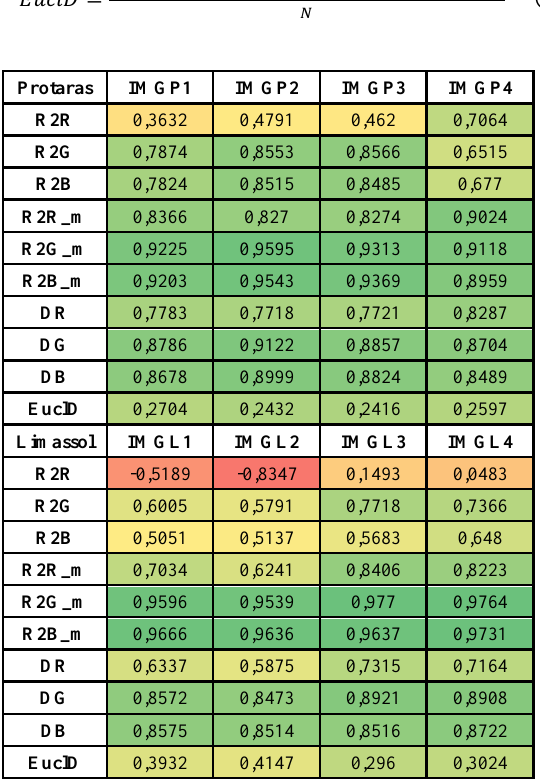
Table 1. The various quantitative metric